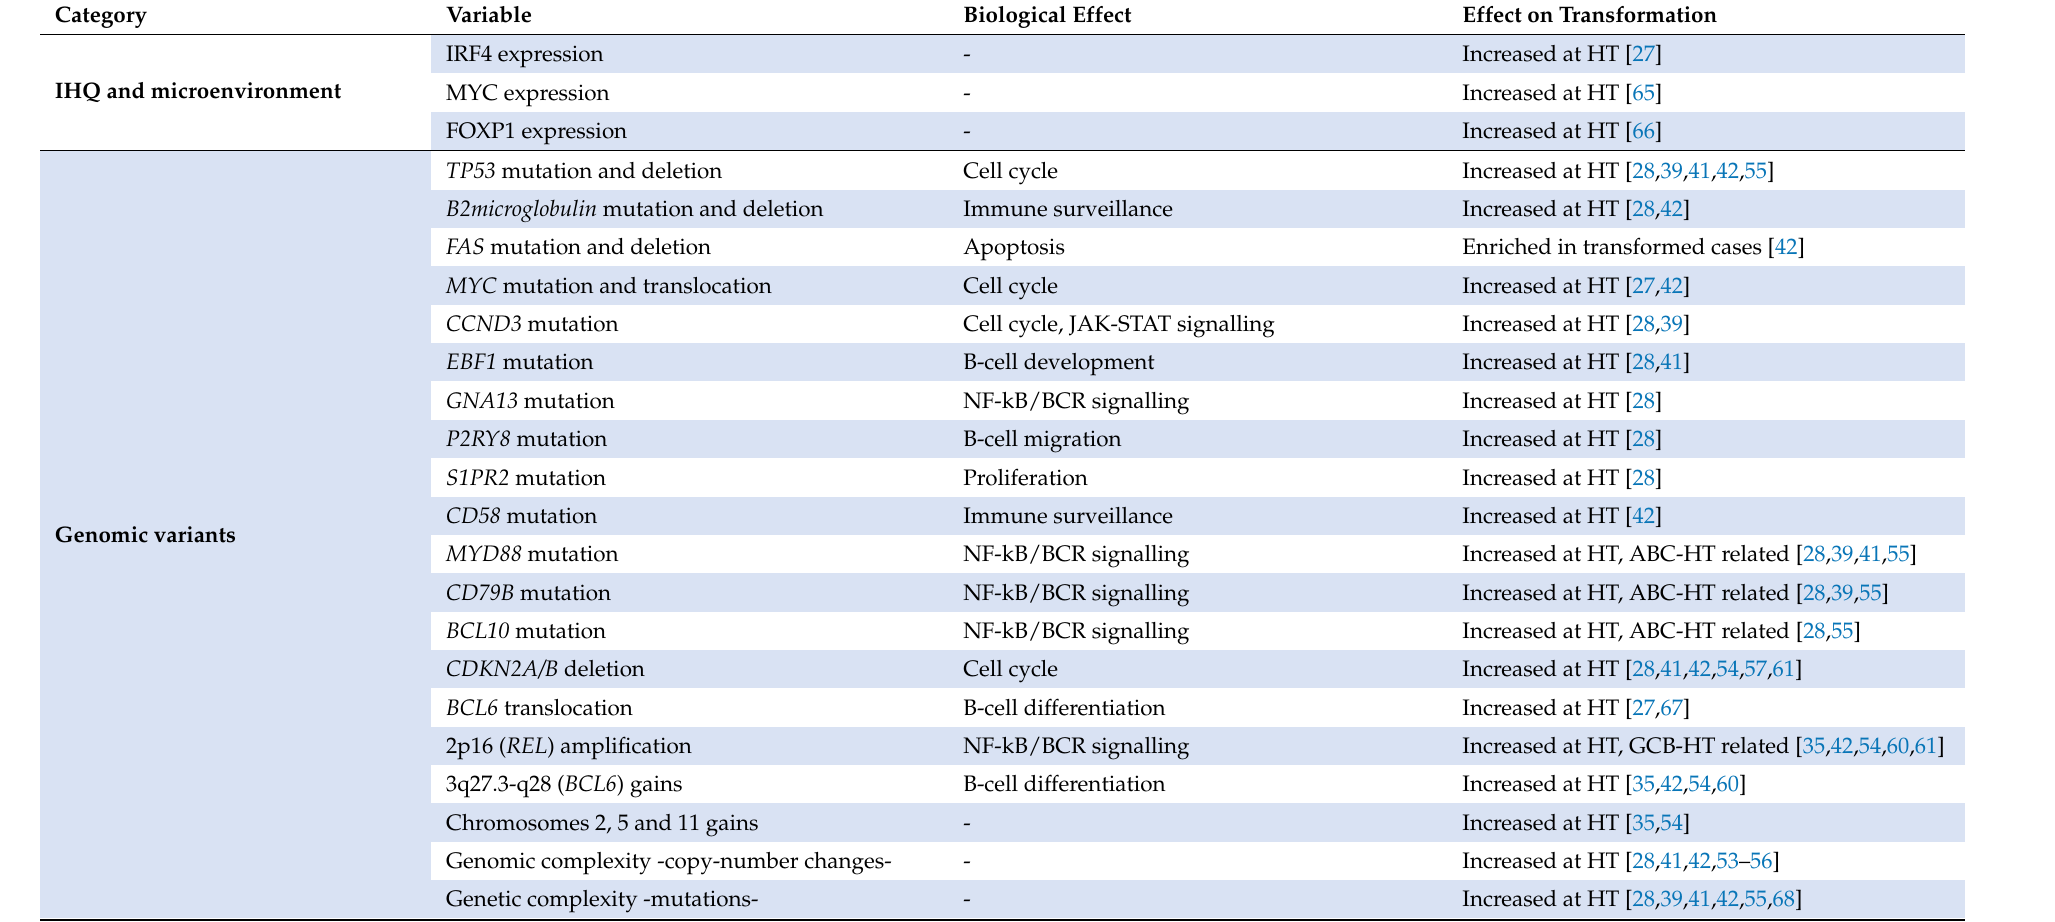
Table 1. Biological and genetic factors enriched at follicular lymphoma histological transformation in the